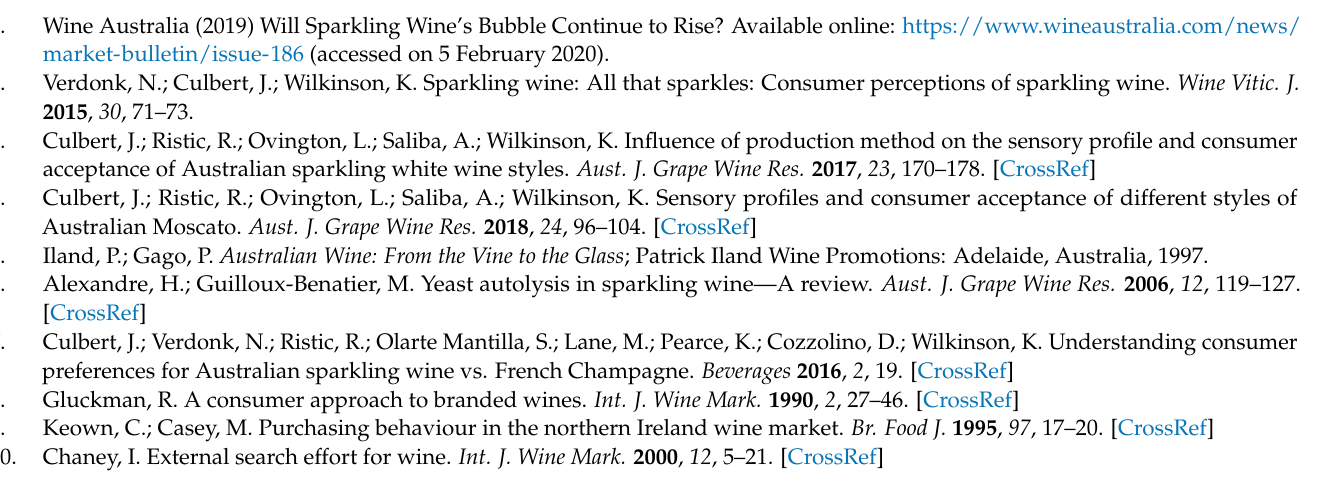
Table S2: Mean intensity ratings for sensory attributes of the French Champagne and Australian sparkling wines studied, Table S3: Alcohol, wine and sparkling wine consumption of consumers and of Fine Wine Instrument consumer segments. Data represent minimum, mean, median and maximum responses (on a percentage scale, i.e., 0–100%), Table S4: Influence of occasion on consumers’ and Fine Wine Instrument consumer segments’ consumption of different sparkling wine styles, Table S5: Statistical analysis for influence of occasion on consumers’ and Fine Wine Instrument consumer segments’ consumption of different sparkling wine